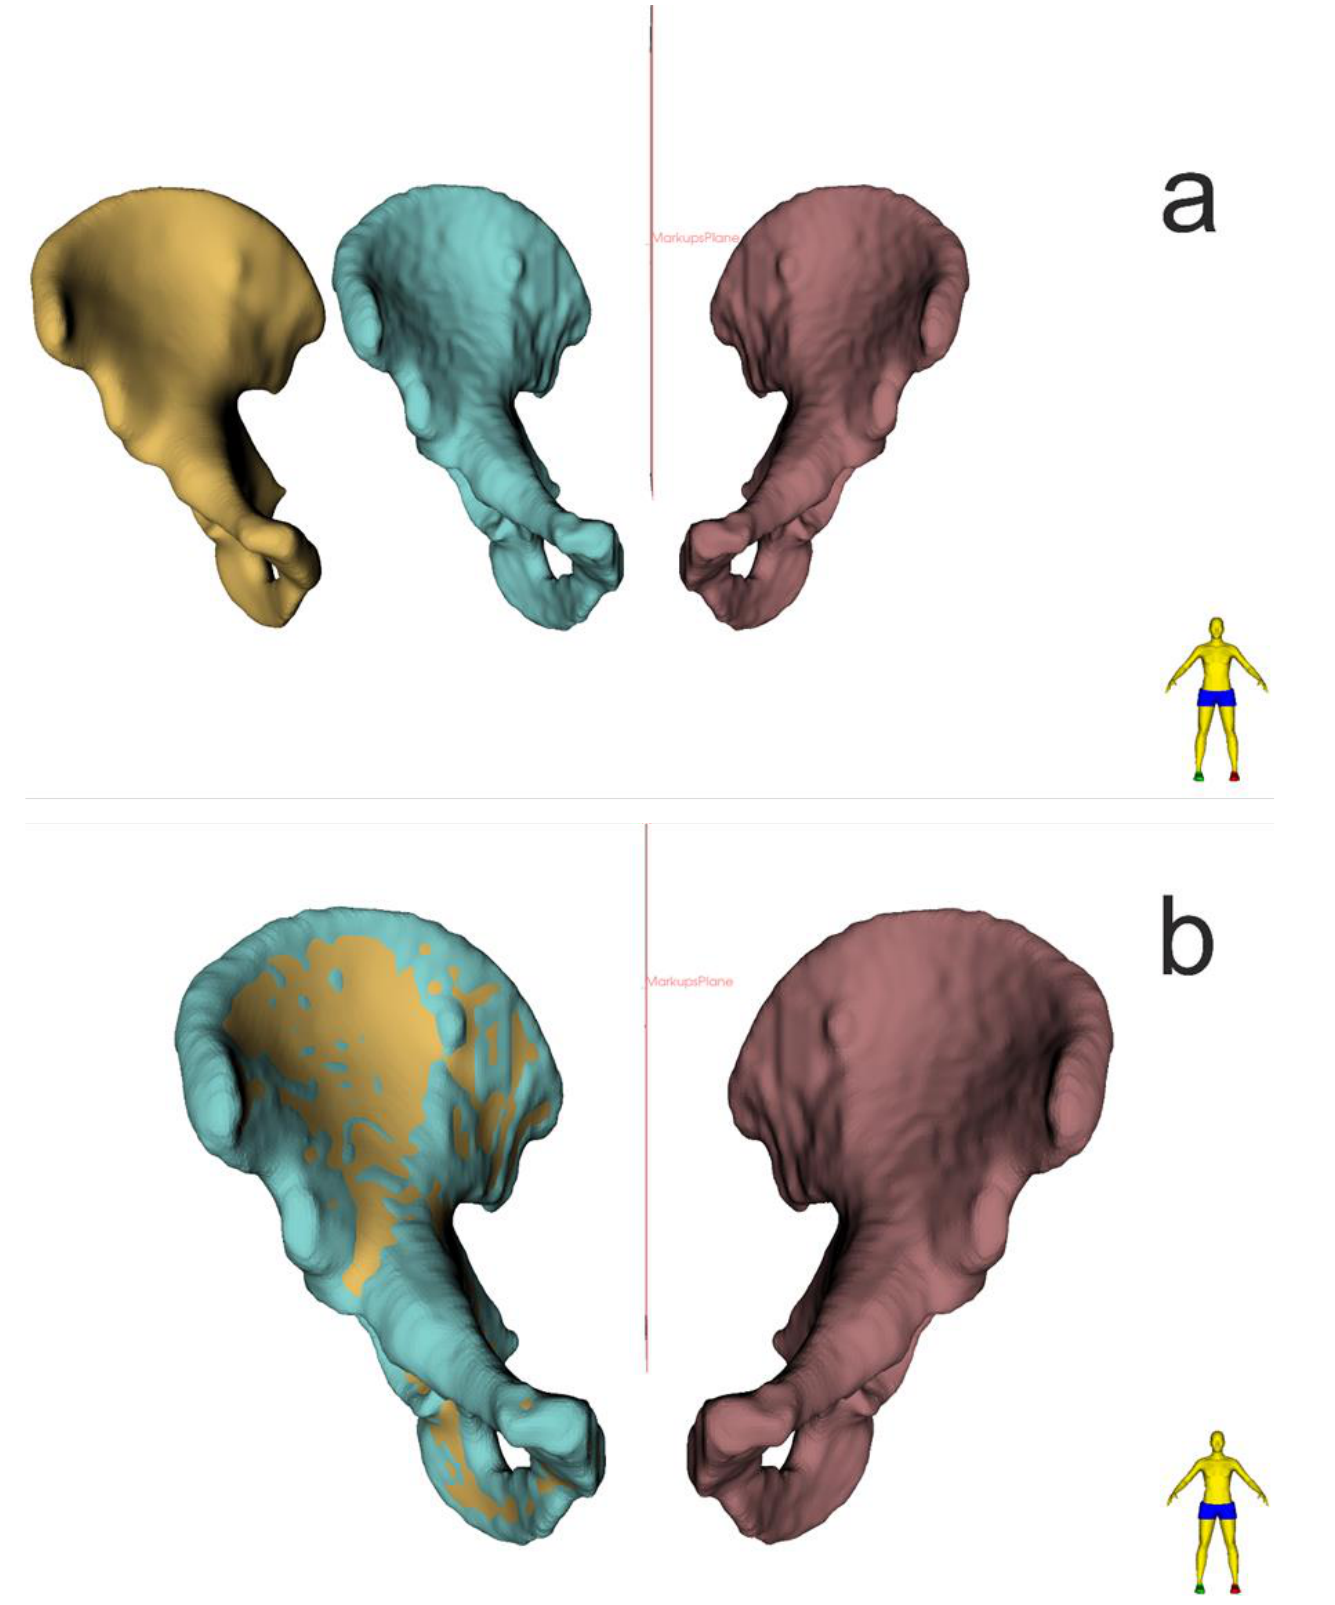
Figure 3. ( a ) Optimization and smoothing of model surface ‘SURFACE TOOLBOX’ module, function ‘Smoothing’ ( b ) 3D comparison analysis of 3D model before and after smoothing (3D Slicer).